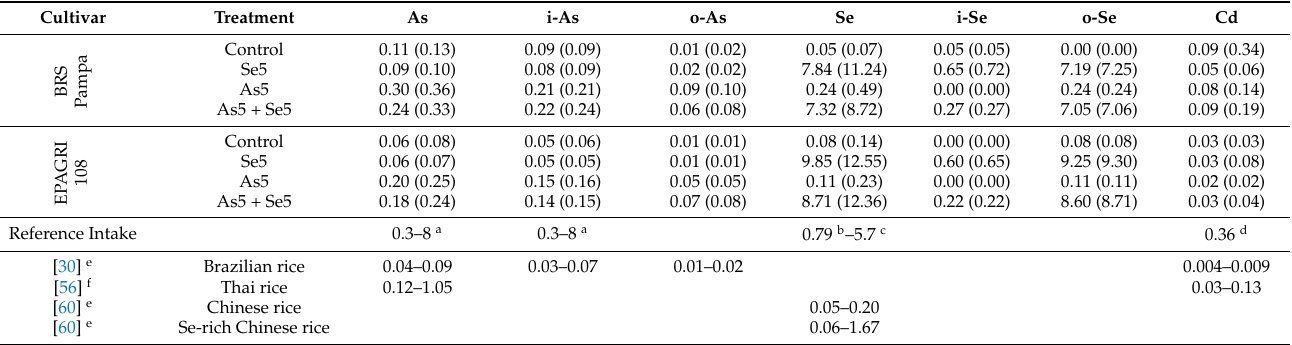
Table 3. Mean and maximum (between parenthesis) estimated daily intake ( µ g kg − 1 BW day − 1 ) of As (total, i-As and o-As), Cd, and Se (total, i-Se and o-Se) through rice